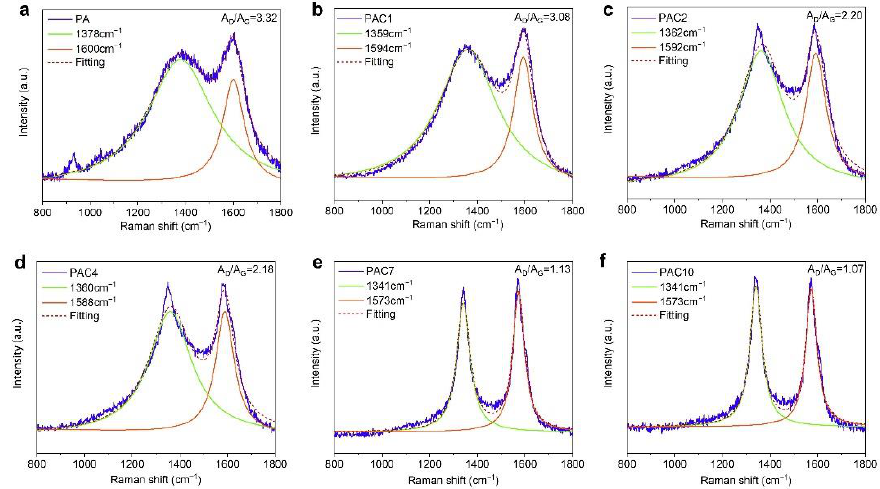
Figure 8. Raman spectra of the char residues of PS composites after CCT: ( a ) PA, ( b ) PAC1, ( c ) PAC2, ( d ) PAC4, ( e ) PAC7, and ( f ) PAC10.